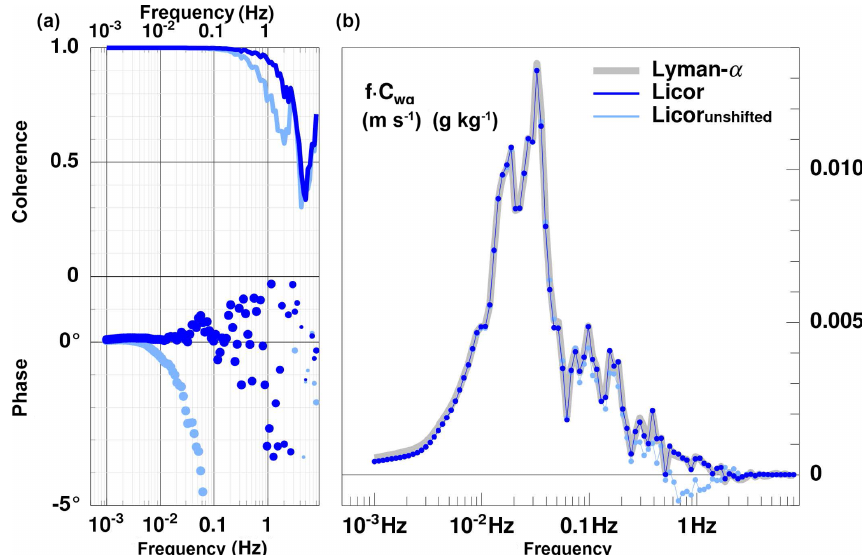
Figure 11. Phase shift and coherence spectra of the shifted (darker blue) and unshifted (light blue) signal of the LI-COR sensor on the Helipod (a) and cospectra of humidity from the different sensors and vertical wind speed multiplied by the frequency (b) on the Helipod flight. The area under the curves is proportional to the humidity fluxes. The flight part indicated in the time series in Fig. 5 in grey was